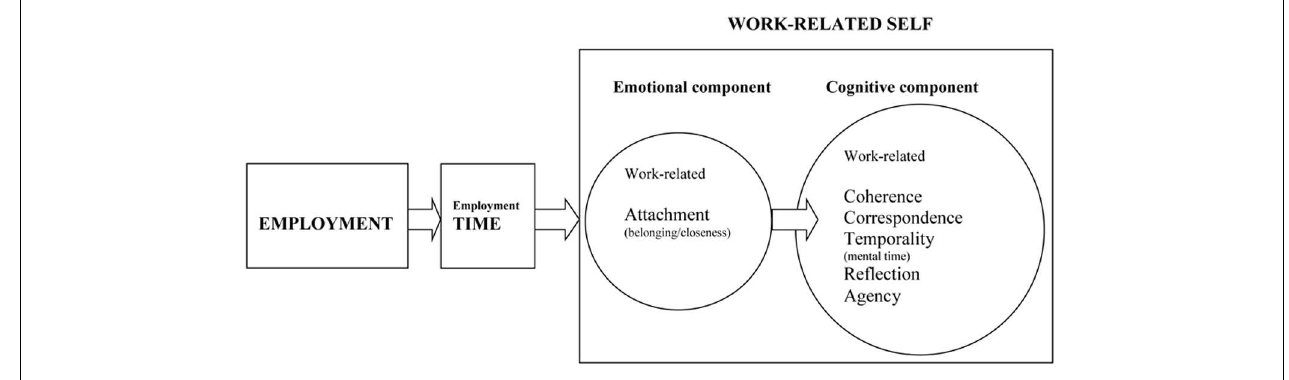
FIGURE 1 | Causal formation of work-related self; from employment across employment time to work-related emotional (attachment/belonging/closeness) and cognitive (coherence, correspondence, temporality/mental time, reflection, agency) components.